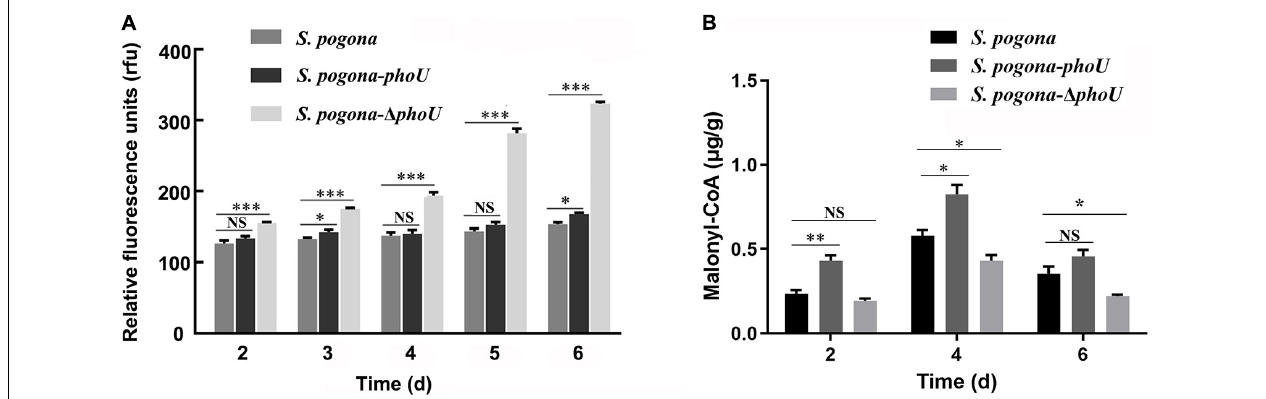
FIGURE 5 | Analysis of intracellular polyP and malonyl-CoA levels in the recombinant and wild-type strains. (A) Intracellular polyP content in wild-type and engineered strains at different time points. (B) Intracellular malonyl-CoA content in wild-type and engineered strains at different time points. The error bars indicate the standard deviations of three biological replicates. *, **, and *** indicate P < 0.05, P < 0.01, and P < 0.005, respectively, NS, no significant difference, compared to Saccharopolyspora pogona under the same conditions.